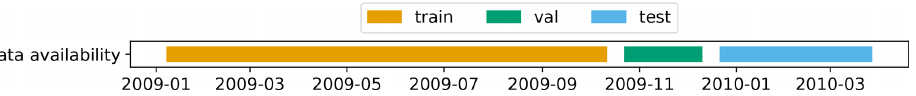
output layer. Here each node corresponds to the prediction for time step t 1 to t 4